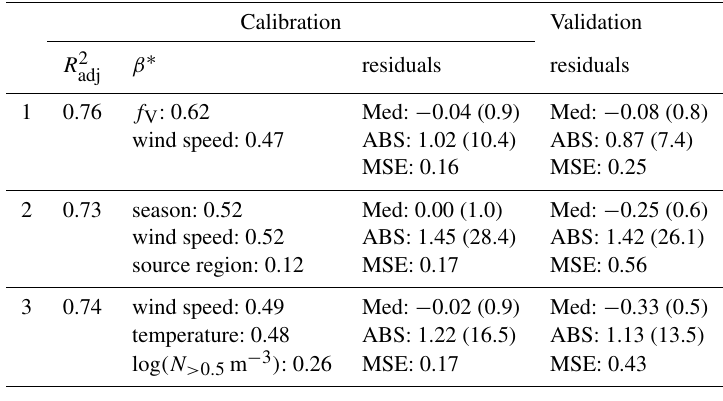
Table 2. Summary of the main statistics employed to evaluate the quality of the models. “ R 2 reproduced by a model. It is adjusted to account for the number of variables and samples considered. All models, parameters, and constants are highly significant ( p < 0 . 001), except the parameter “source region” ( p = 0 . 06). “ β ∗ ” is the value of the standardised regression coefficients, expressing the relative importance of each parameter in a model. The “residuals” column shows the median residual value “med” and the maximum absolute residual as maximum estimation error “ABS” (the corresponding factors of error estimate on linear scale are shown in brackets). “MSE” is the value of the mean squared error.